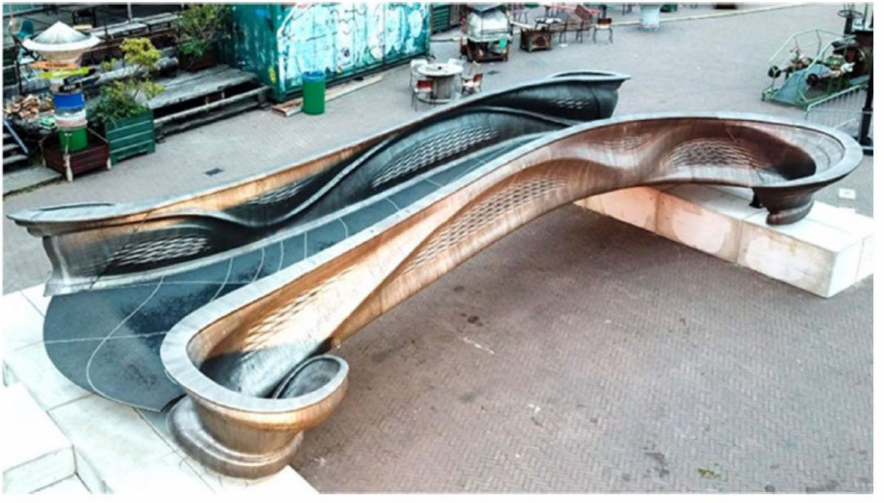
Figure 5. WAAM made bridge [14].